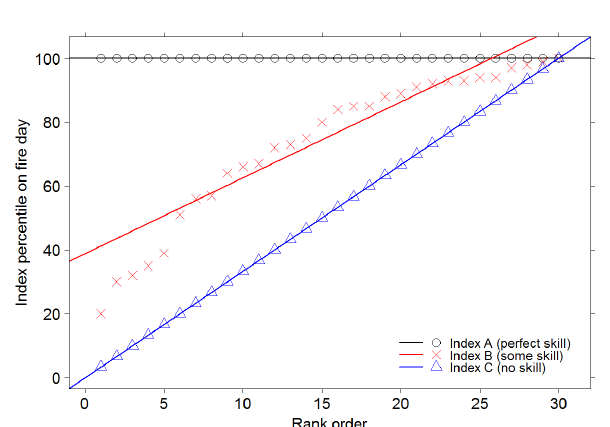
Figure 1. Demonstration of the use of data from three hypothetical fire danger indices (indices A, B and C) fitted with Theil–Sen mod- els to compare the indices’ predictive skill on fire days. Index A demonstrates perfect skill (i.e. the highest index percentile value possible occurs on each fire day) and so slope = 0 and intercept = 100 for the Theil–Sen model fit to these data. The model fit to in- dex B (which shows some predictive skill) has a smaller intercept and larger slope than the model fit to index A but a larger intercept and smaller slope than the model fit to index C (an index with no predictive skill). Accordingly, by comparing the slope and/or inter- cept values of Theil–Sen models fit to percentile data from two or more fire danger indices, the relative predictive skill of the indices can be determined. See Eastaugh et al. (2012) for more details on this approach to skill